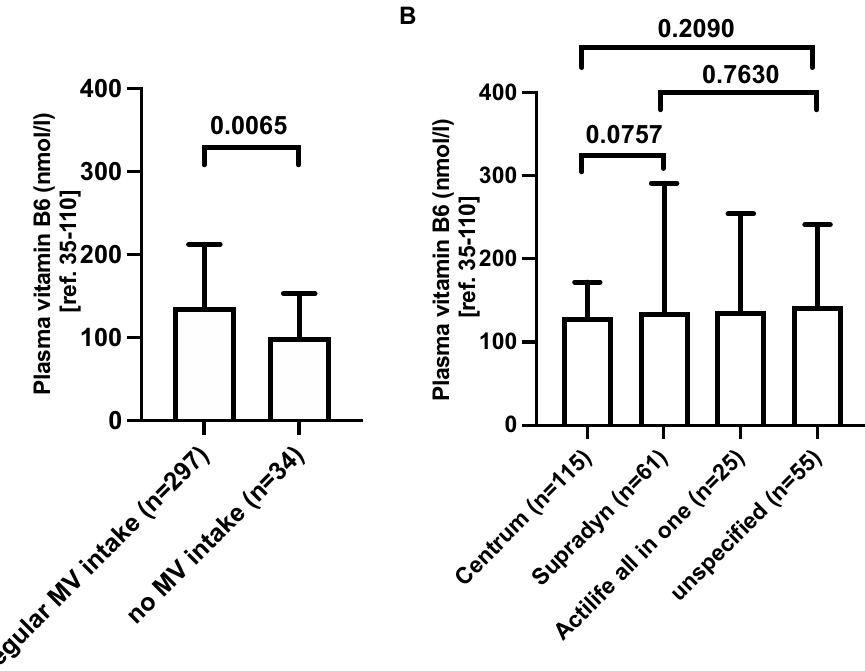
Figure 4. Plasma vitamin B6 levels and multivitamin supplementation intake in post-bariatric patients. ( A ) Presented are median plasma vitamin B6 levels and interquartile ranges (IQR) in patients with regular multivitamin (MV) intake (137 nmol/l, IQR 99–213) compared to patients who reported no regular multivitamin supplementation (101 nmol/l, IQR 73–153). ( B ) Plasma vitamin B6 levels in patients with recorded intake of the most common multivitamin compounds compared to those with recorded intake of multivitamin supplements without specification of the name of the compound (“unspecified”). Data are presented as median and interquartile ranges. Mean values were 145 nmol/l (IQR 102–172), 216 nmol/l (IQR 99–285), 210 nmol/l (IQR 101–221), and 202 nmol/l (IQR 96–241) in patients taking “Centrum von A bis Zink” (vitamin B6 content: 2 mg per serving), “Supradyn energy” (vitamin B6 content: 4 mg per serving), “Actilife all in one Depot” (vitamin B6 content: 1.4 mg per serving), and unspecified multivitamin compounds, respectively. Kruskal–Wallis-Test for intergroup comparison was not significant (p-value 0.28). Level of significance between two groups was calculated with Mann–Whitney U-test and is indicated in the graph with horizontal bars. n number of plasma vitamin B6 measurements in 205 patients in